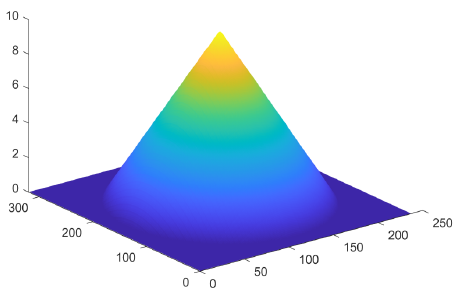
Figure 13. The 3D scatter model (Ground truth).